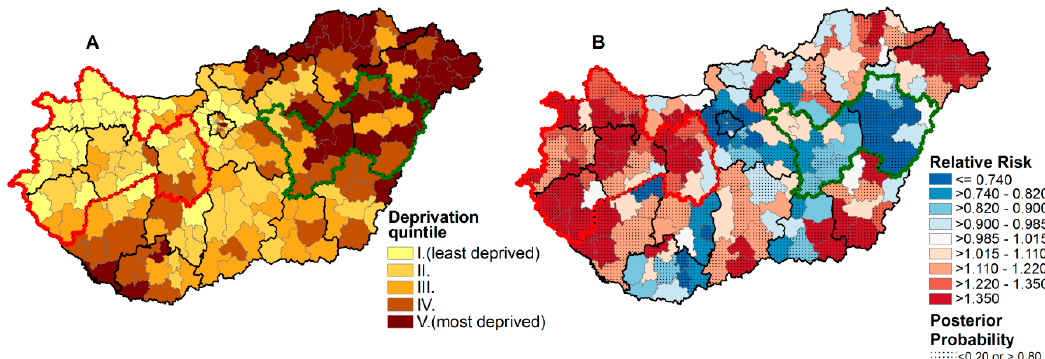
Figure 1. The spatial distribution of deprivation ( A ) and mortality risk in the age group 40+ years due to thromboembolic diseases (ICD-10.: I63-I64, I74, I80-I82) ( B ), Hungary, 2016. A cluster of counties least deprived with a high mortality rate is bordered by a red line, while another cluster of counties highly deprived with low mortality rate is bordered with a green line.